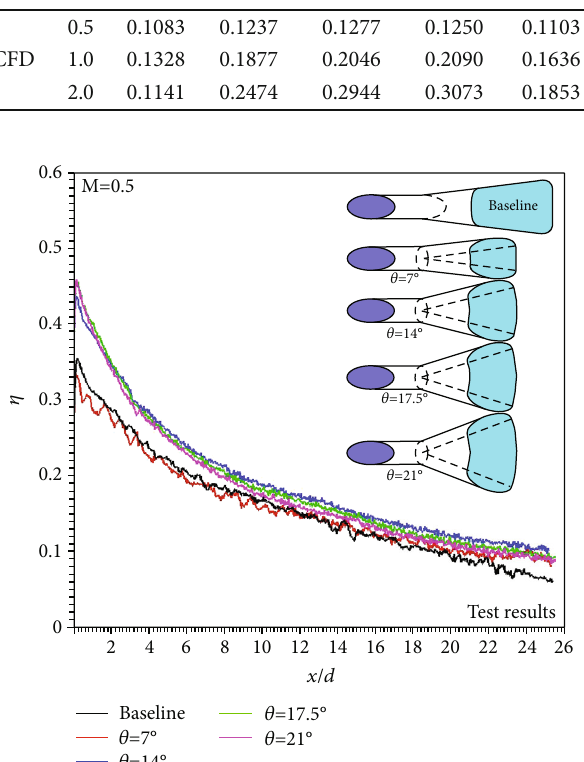
Figure 20: Streamwise variation of measured fi lm e ff ectiveness (spanwise-averaged at each point) for the blowing ratio of 0.5.